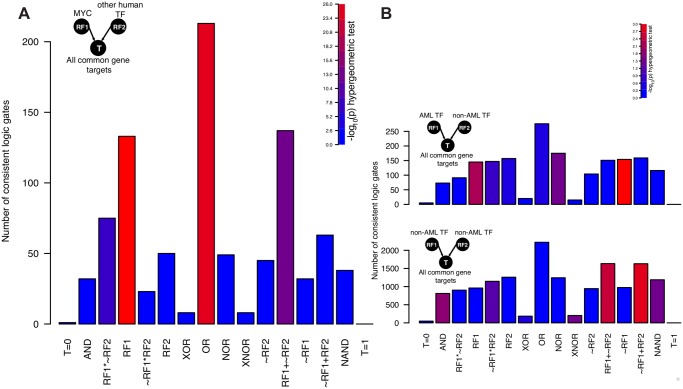
Distributions by logic gate of gate-consistent human regulatory triples associated with AML-related TFs.The bar color represents-log10(hyper-geometric enrichment p-value) (Materials and Methods). A—The triplets in which RF1 is MYC, RF2 is chosen from other human TFs, and T is a common target. The two most enriched logic gates are “T = RF1” (133 triplets, hyper-geometric test p(133, 2153, 1110, 50865)< 4.3*10-27) and “T = RF1+RF2 (OR)” (211 triplets, hyper-geometric test p(211, 2153, 2505, 50865)< 1.1*10-21), which supports the finding that MYC is a universally amplifier for its target expression; B—the triplets in which RF1 is chosen from AML-related TFs, RF2 is chosen from TFs not relating to AML, and T is a common target as shown in top, and the triplets in which both RF1 and RF2 are chosen from TFs not relating to AML, and T is a common target as shown in bottom. “T = RF1” and “T = ~RF1” are the two most enriched matched logic gates when RF1 is AML-related TF, which implies that AML-related TFs dominate the regulation of their target expression.